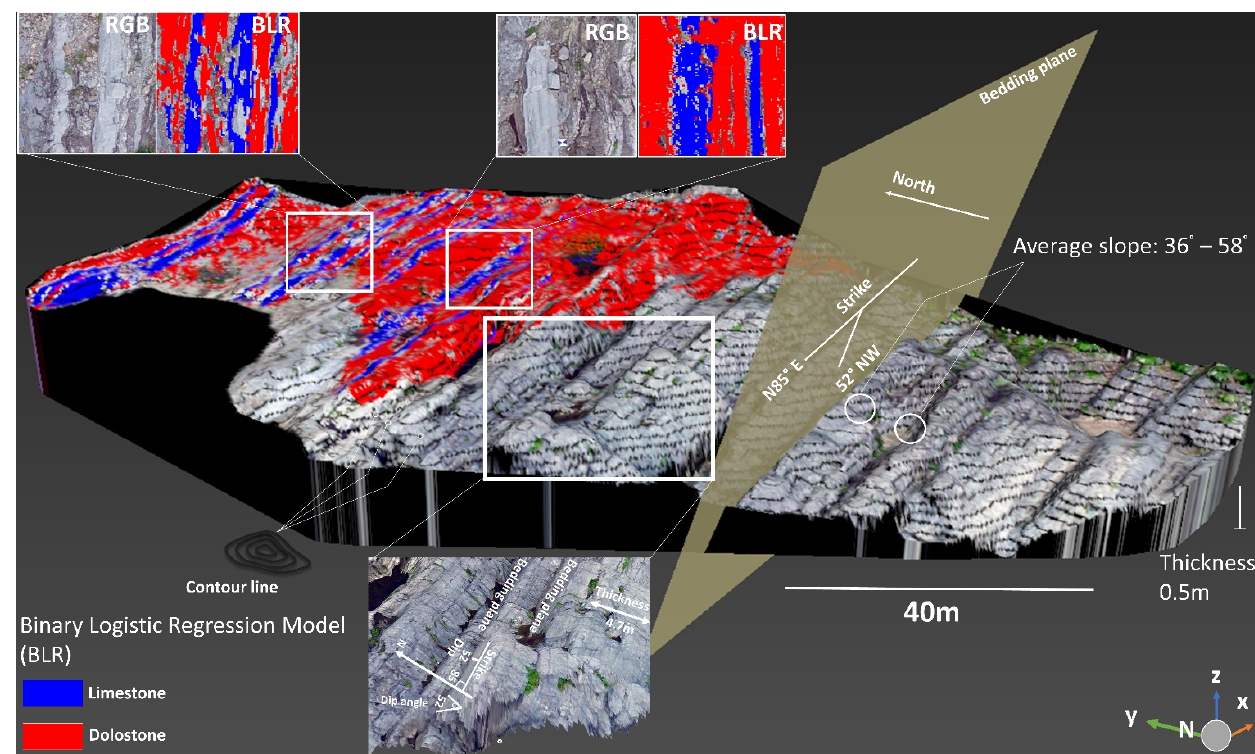
Figure 9. Fusion of hyperspectral imaging derived from binary logistic regression model (BLR) overlain on RGB UAV-based 3D model showing lithological distribution and geological positioning of the rock layers.